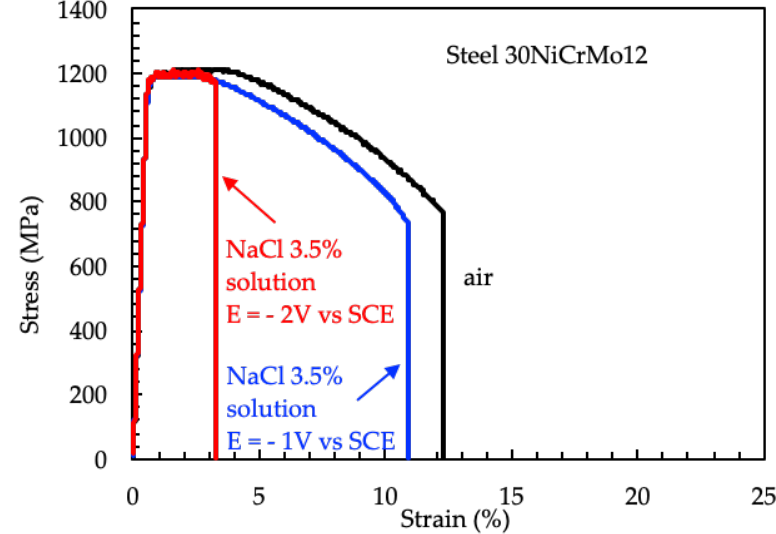
Figure 12. Stress vs. strain curves of the 30NiCrMo12 steel in air and in NaCl 3.5% solution with cathodic protection.